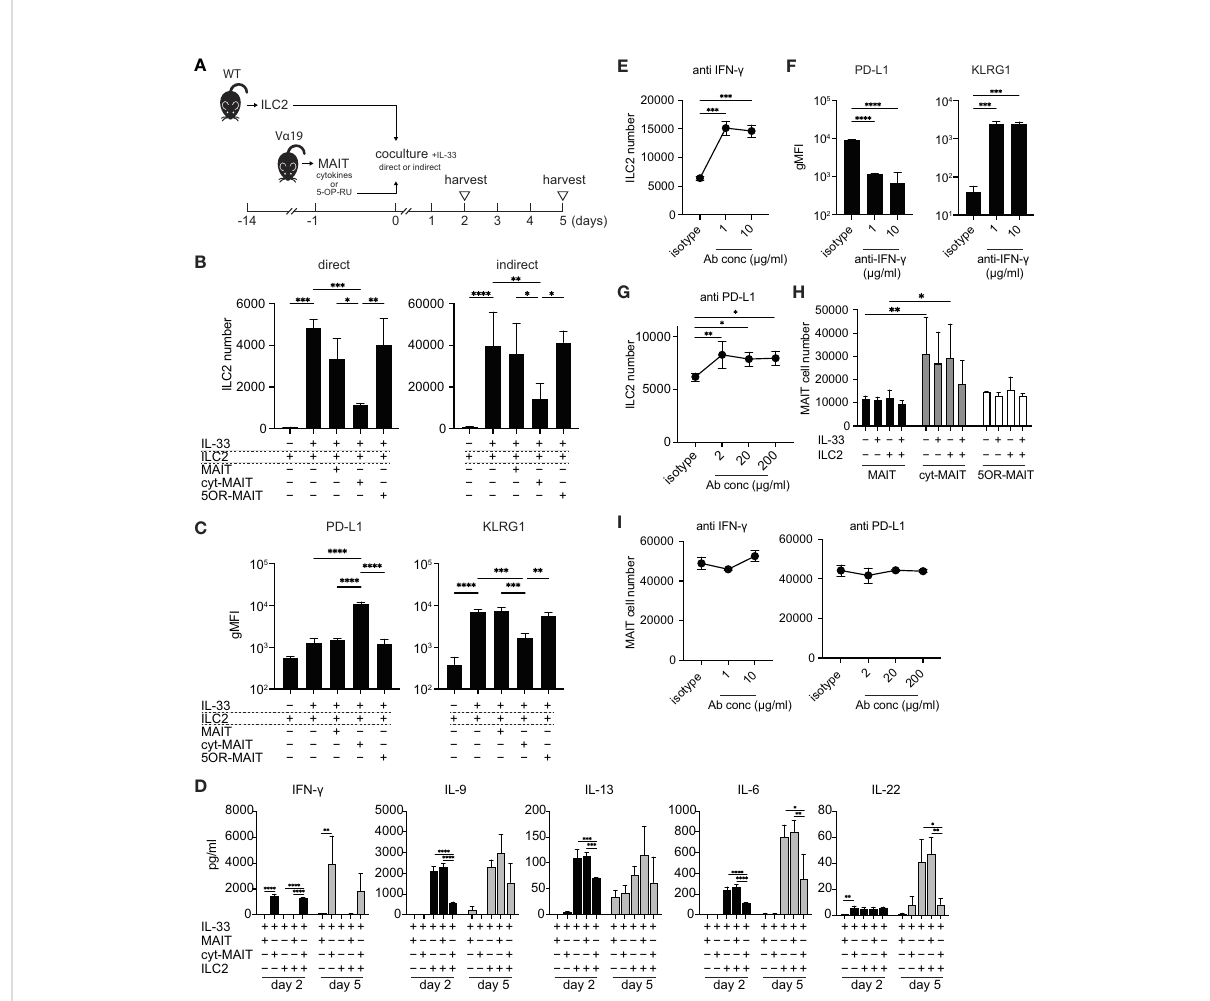
FIGURE 3 Compromised cytokine production by and proliferation of ILC2s by MAIT cells (A) Schematic representation of the experiment. ILC2s prepared from wild-type mice (5 × 10 3 cells) and MAIT cells (5 × 10 3 cells) from V a 19 mice that were sham-treated, treated with IL-12 (10 ng/ml), IL-15